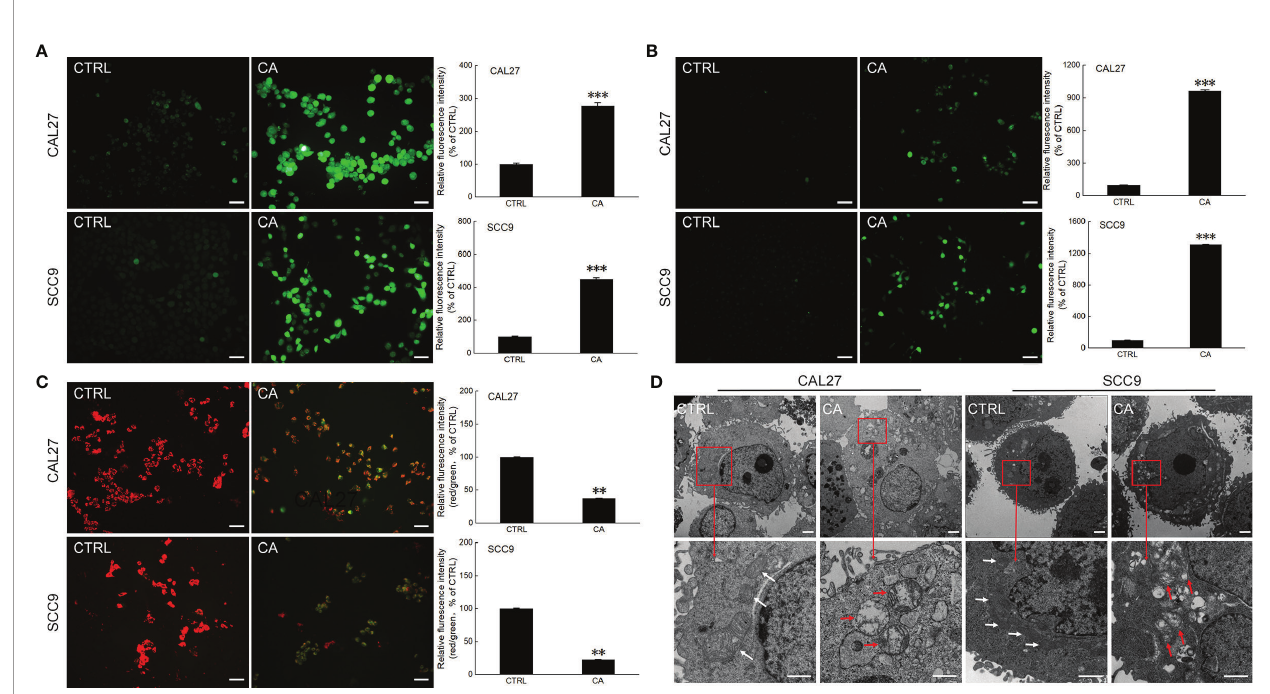
FIGURE 2 | CA treatment affected the mitochondrial function in OSCC cells. CA treatment increased the intracellular (A) ROS and (B) Ca 2+ levels and induced the (C) dissipation of the MMP in CAL27 and SCC9 cells ( n = 3, 200× magni fi cation, scale bar: 50 m m). (D) CA affected the structure of the mitochondria in OSCC cells observed by transmission electron microscope (TEM) ( n = 3, 700× magni fi cation, scale bar: 5.0 m m; 3000× magni fi cation, scale bar: 1.0 m m). The quantitation results are expressed as percentages relative to the levels in the corresponding control cells, and the data are expressed as mean ± SEM. ** P < 0.01 and *** P < 0.001 versus the control